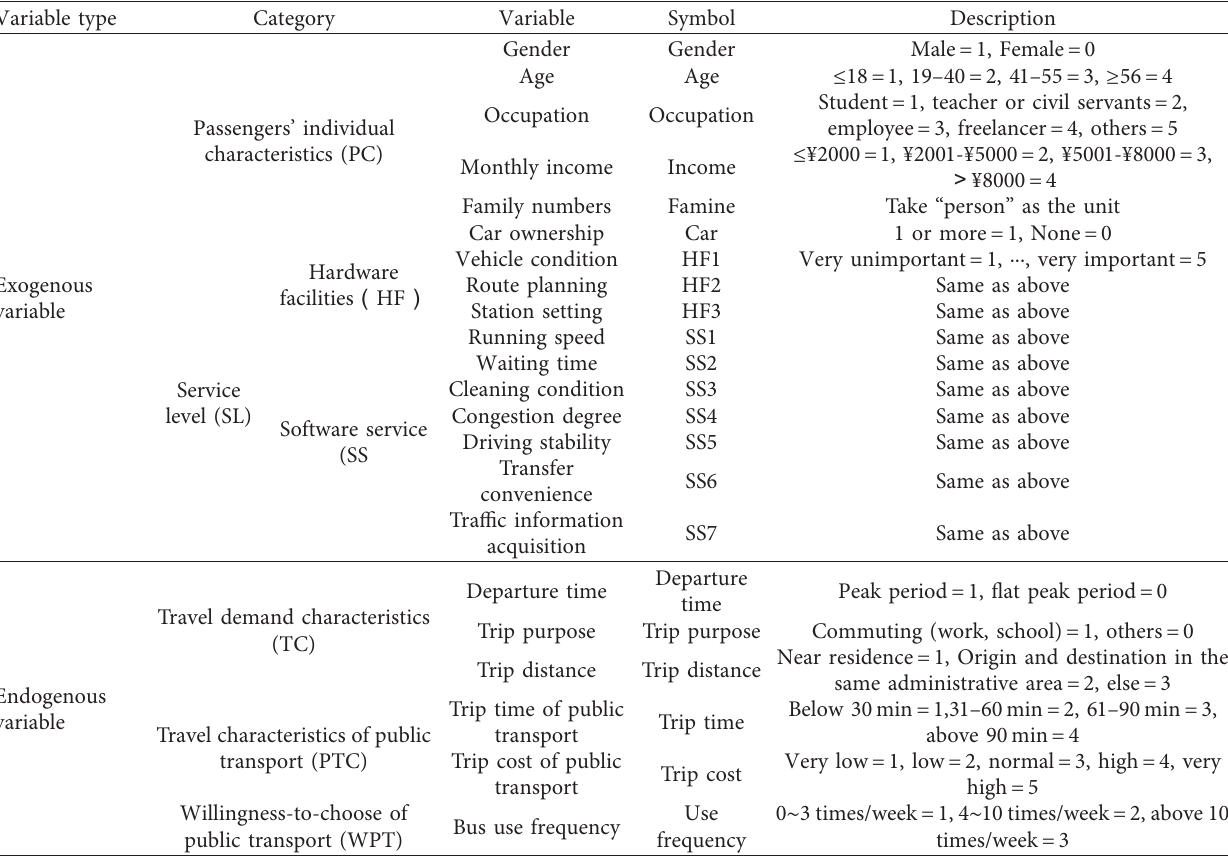
Figure 7: Structural model of the willingness-to-choose of public transport. Table 2: Description of initial model